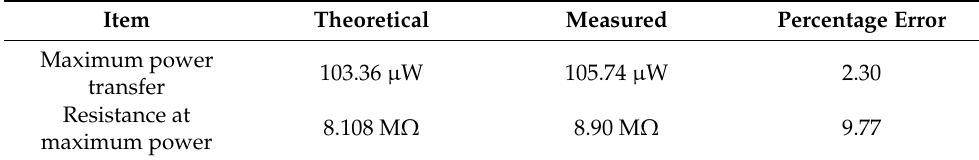
Table 3. Theoretical and measured maximum power and load resistance at maximum